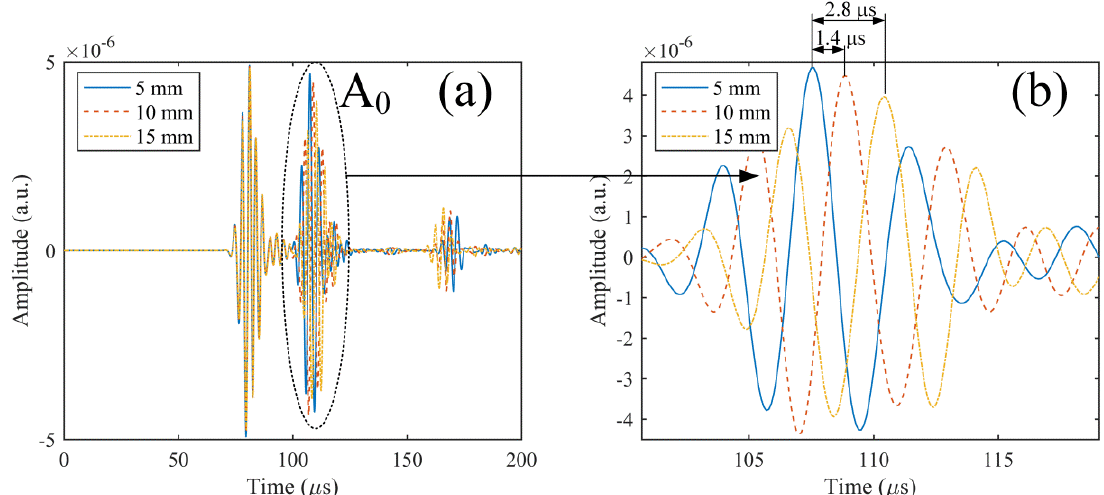
Figure 11. ( a ) Calculation results corresponding to the adhesive lengths of 5, 10, and 15 mm; and ( b ) magnification of the waveform components corresponding to A 0